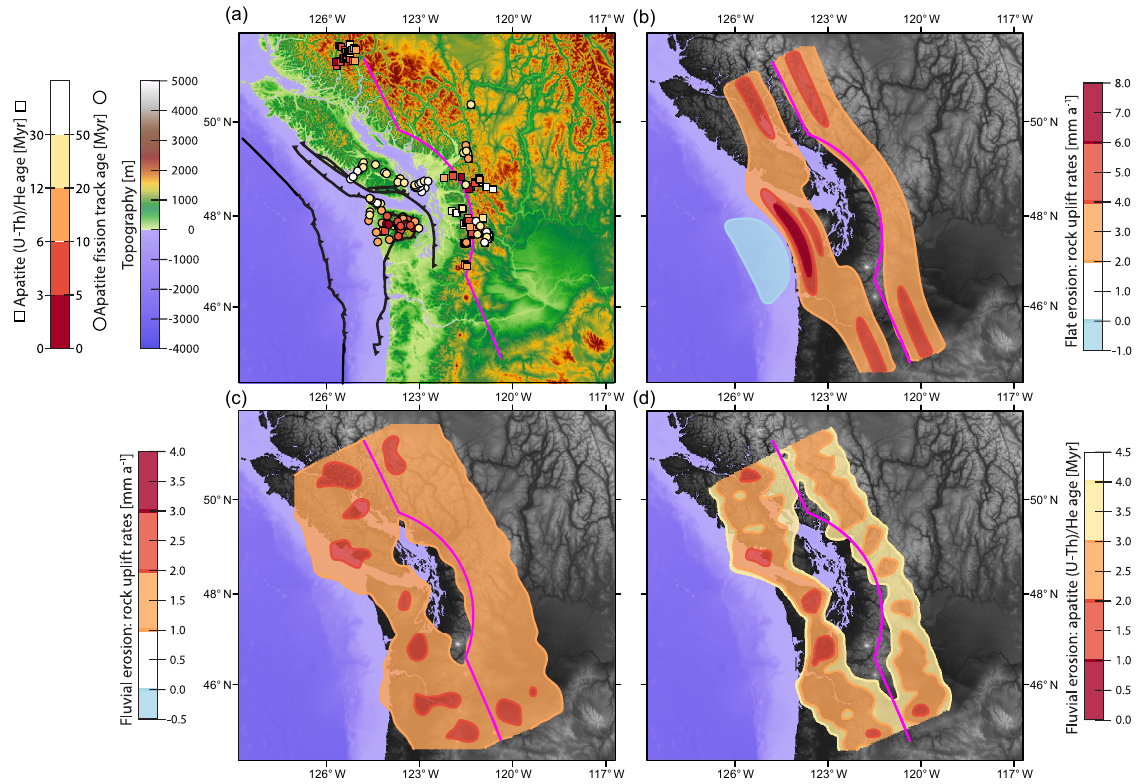
Figure 9. Comparison of Cascadia topography with model results: (a) apatite (U − Th) / He (squares; Batt et al., 2001; Ehlers et al., 2006; Reiners et al., 2002, 2003; Simon-Labric et al., 2014) and apatite fission track cooling ages (circles; Brandon et al., 1998; England et al., 1997; Currie and Grist, 1996; Reiners et al., 2002; Johnson et al., 1986). Major structures from Brandon et al. (1998). (b) Flat erosion (model 5) rock uplift rates. (c) Fluvial erosion (model 11) rock uplift rates and (d) fluvial erosion (model 11) predicted apatite (U − Th) / He cooling ages. Model S line in magenta for orientation. The region of increased uplift above the indenter for the flat erosion model coincides with the location of the Olympic Mountains. The fluvial erosion model shows smaller variations in rock uplift rates and cooling ages that are roughly the same size as the extent of young cooling ages in the Olympic